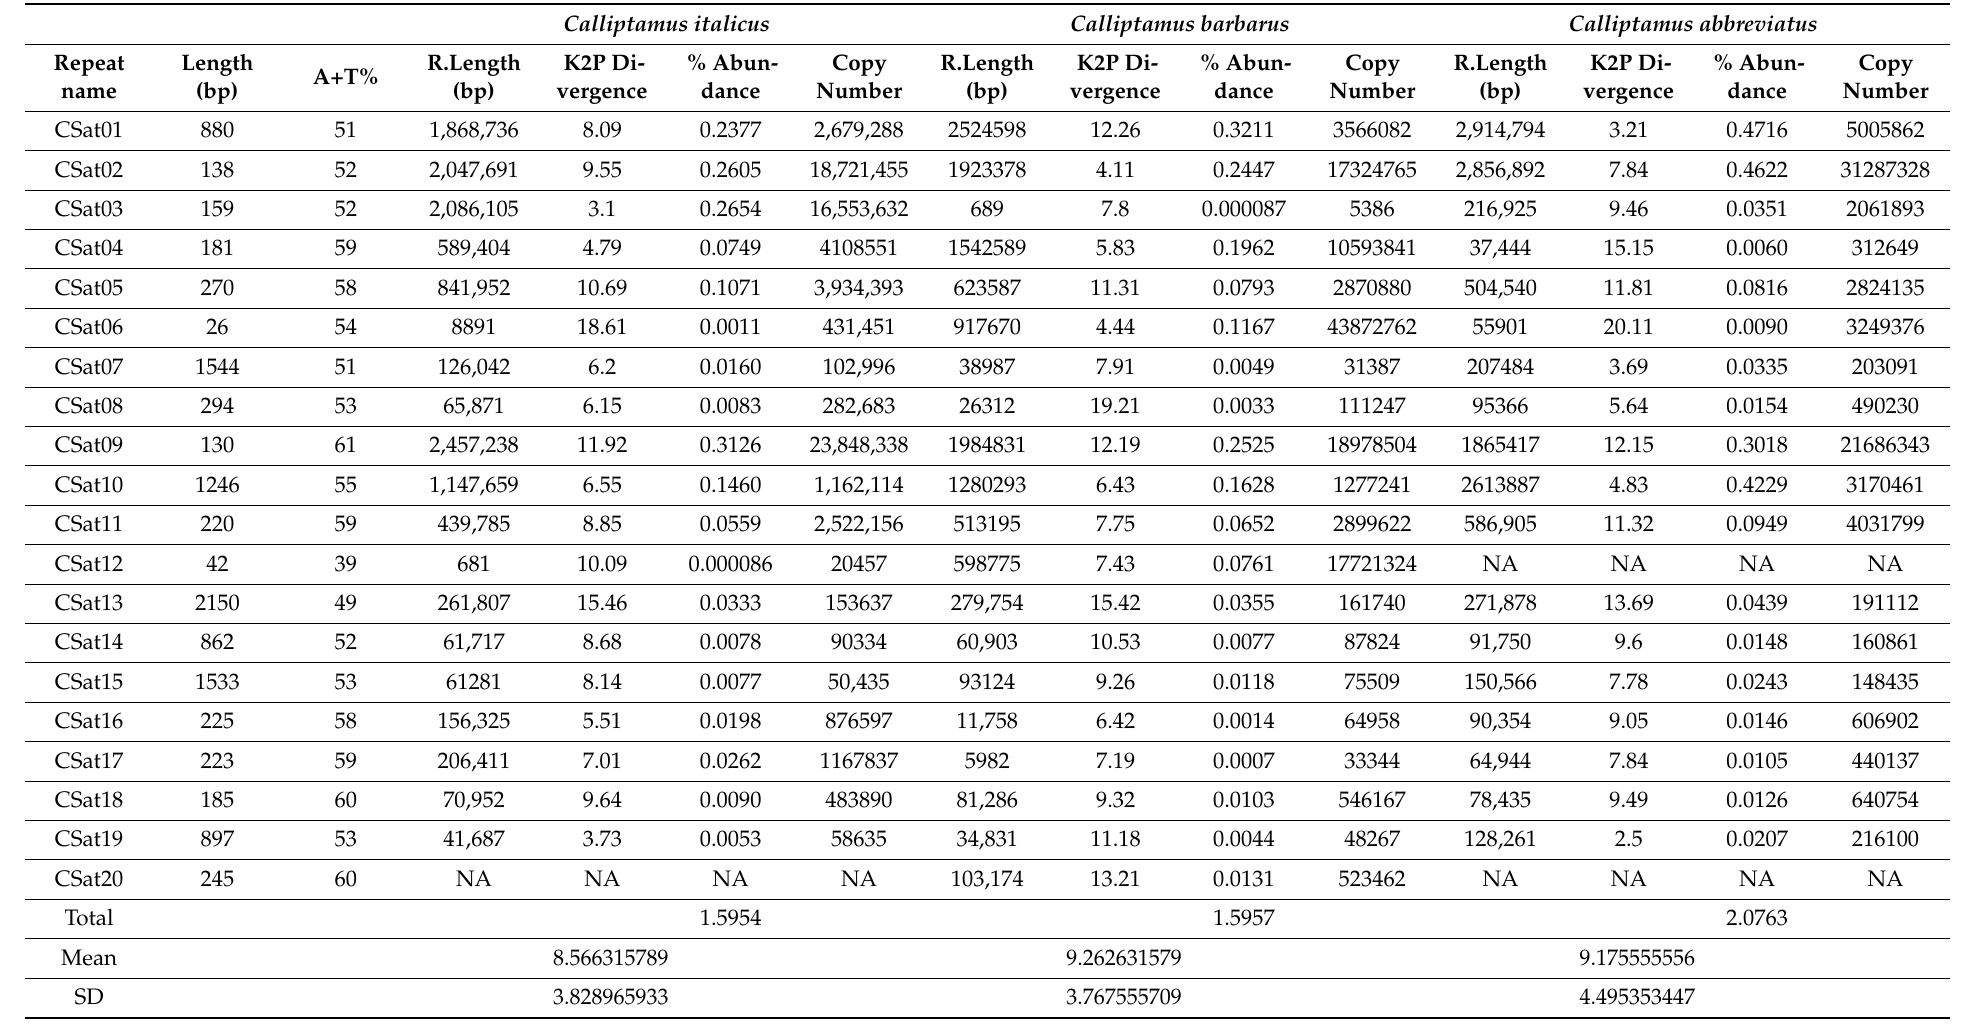
Table 1. The table contains the divergence%, abundance%, copy number for Calliptamus italicus, Calliptamus barbarus, and Calliptamus abbreviatus estimated by using Repeatmasker, as well as A+T percentage of each satDNA